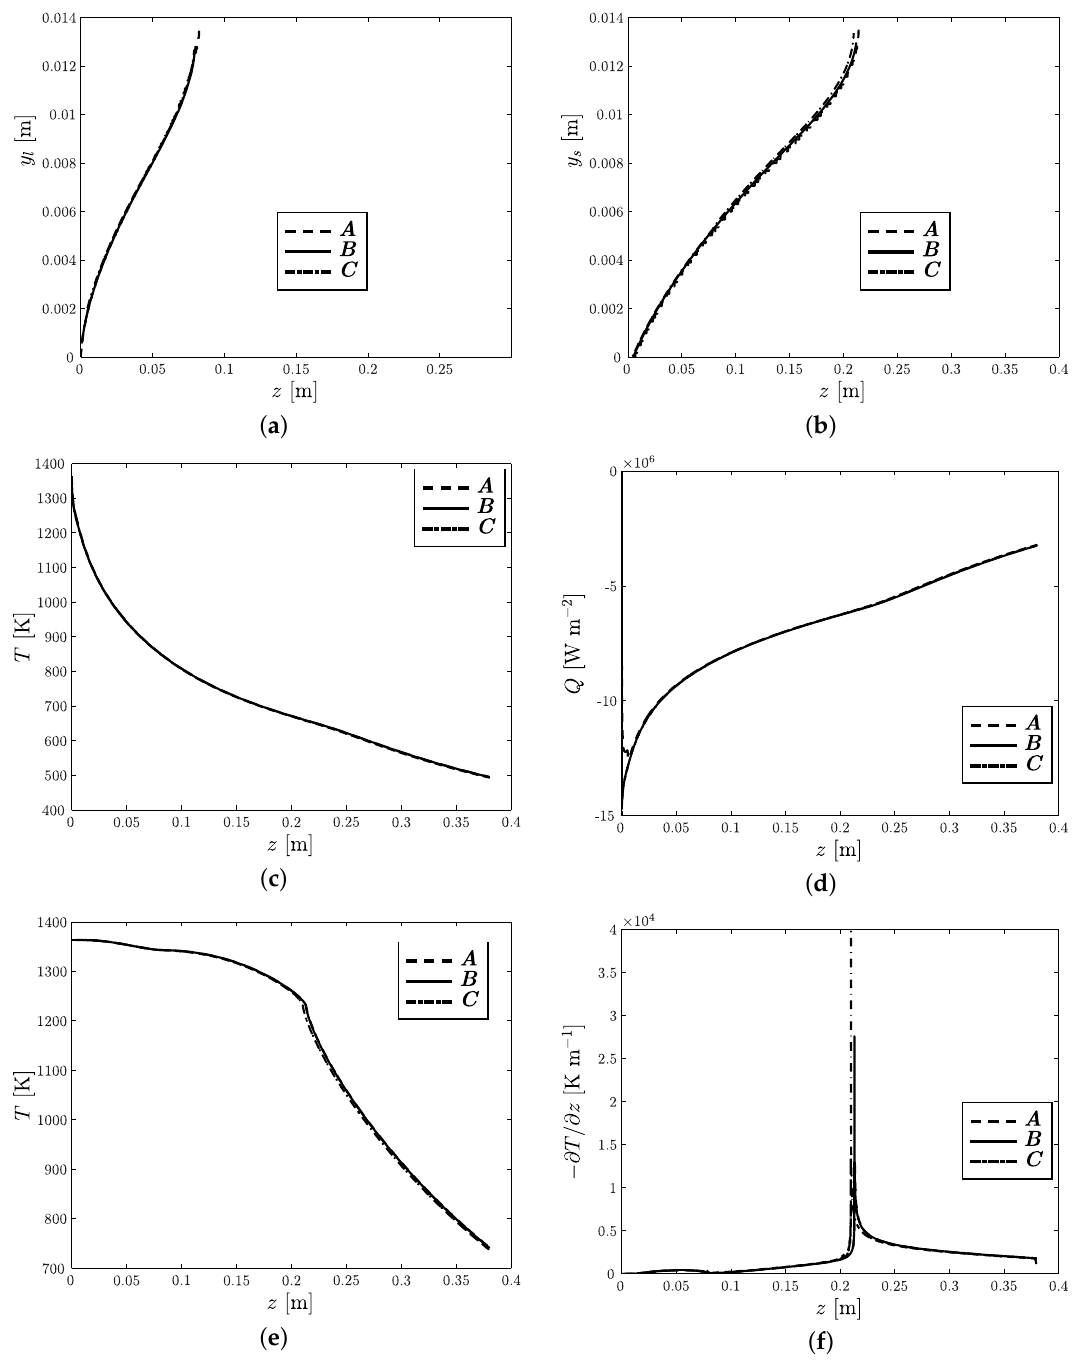
Figure 6. ( a ) The location of the liquidus isotherm, y l ; ( b ) the location of the solidus isotherm, y s ; ( c ) mould wall temperature; ( d ) mould wall heat flux, Q ; ( e ) centreline temperature; and ( f ) at the centreline. All quantities are given as functions of z . Reproduced from [22], with copyright permission from Elsevier,